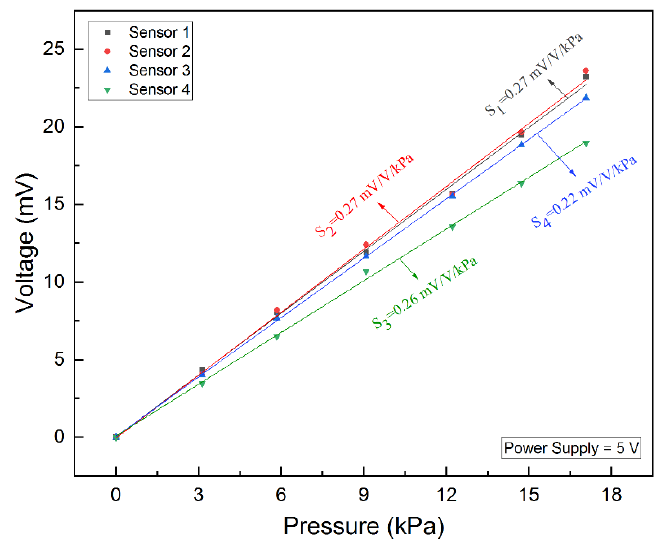
Figure 17. Sensitivity measurement result of the transferred tactile sensors.